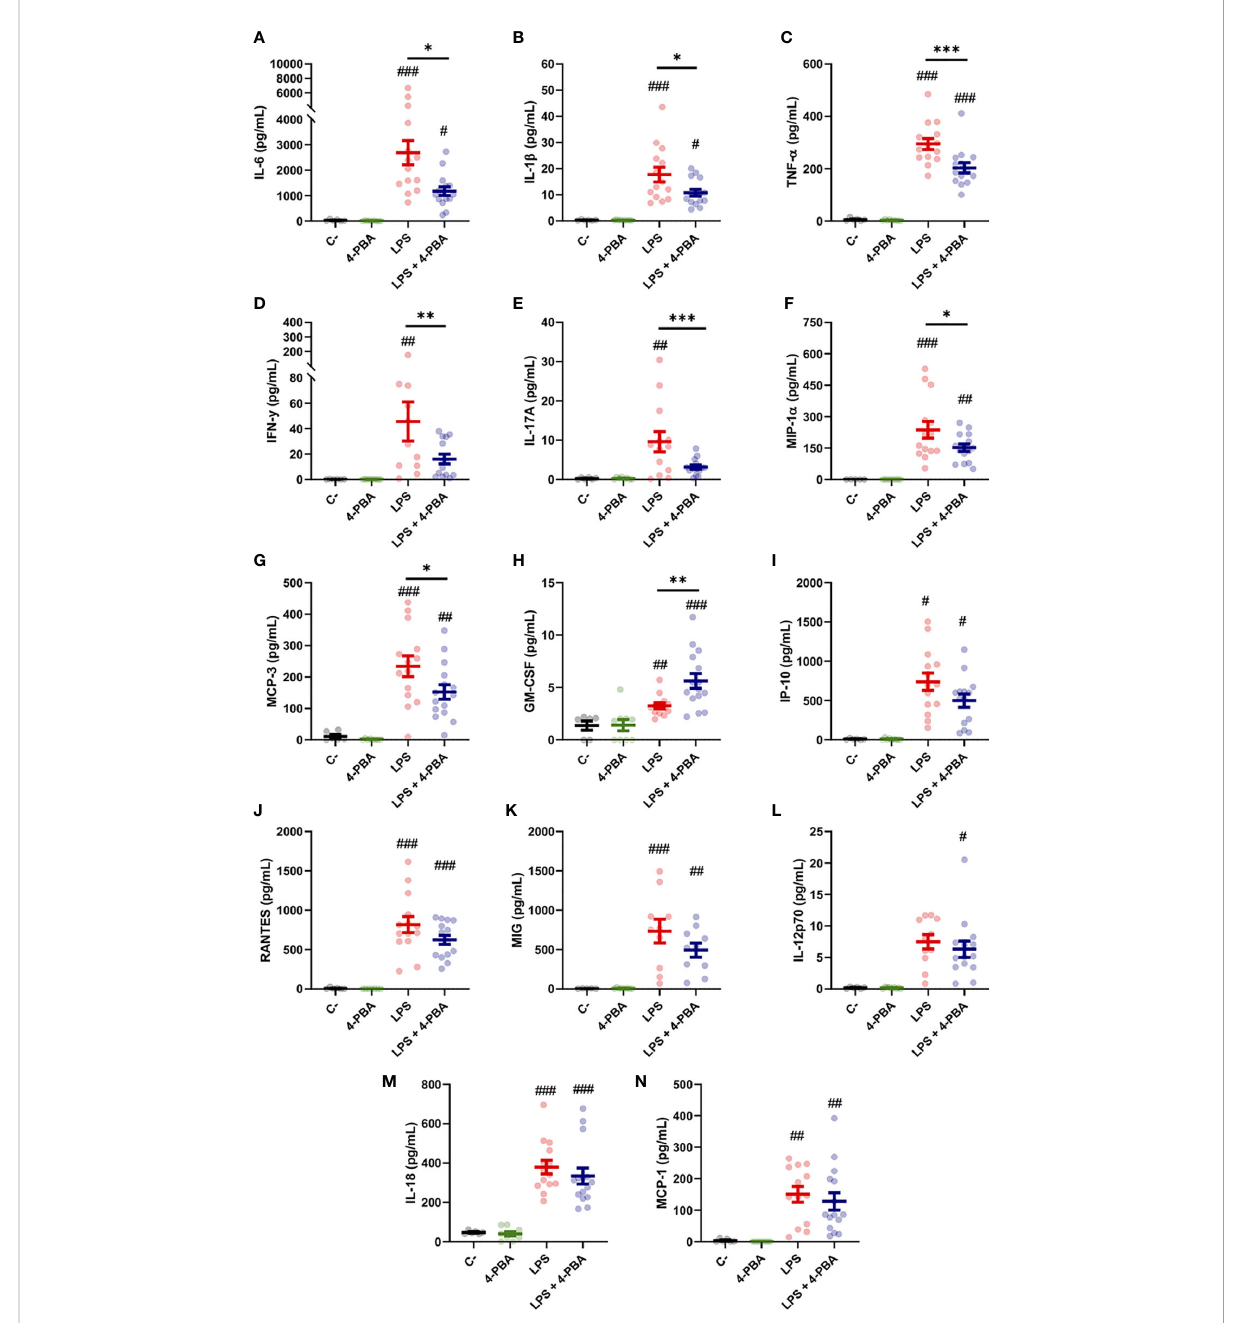
FIGURE 2 Bronchoalveolar cytokine pro fi le after LPS challenge and 4-PBA treatment in ARDS model. (A – N) Levels of cytokines IL-6, IL-1 b , TNF- a , IFN- g , IL-17A, MIP-1 a , MCP-3, GM-CSF, IP-10, RANTES, MIG, IL-12p70, IL-18 and MCP-1 in BALF from mice challenged with LPS without 4-PBA treatment ( LPS , n=14, graphed in red) and with 4-PBA treatment ( LPS + 4-PBA , n=15, graphed in blue). Groups of unchallenged mice without 4- PBA ( C- , n=6, graphed in black) and with 4-PBA treatment ( 4-PBA , n=9; graphed in green) were also evaluated. Colored lines and whiskers denote mean ± SEM for every data set. Hash marks indicate signi fi cant difference versus non-LPS challenge conditions ( # P < 0.05, ## P < 0.01, ### P < 0.001) and a straight line between LPS and LPS + 4-PBA (* P < 0.05, ** P < 0.01, *** P < 0.001) by Two-way ANOVA followed by Tukey ’ s post-hoc